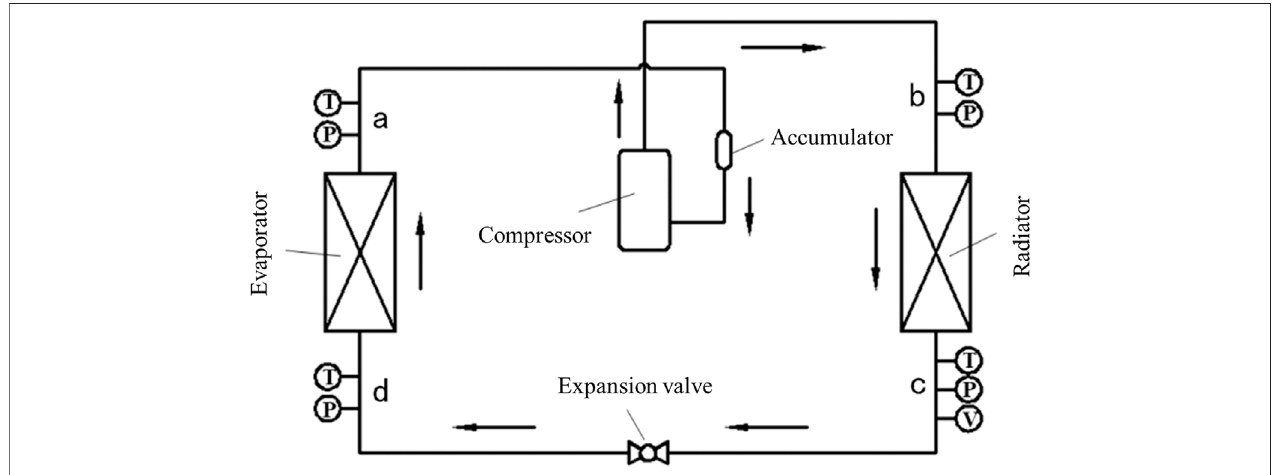
FIGURE 2 | Schematic of the proposed ASHP system.